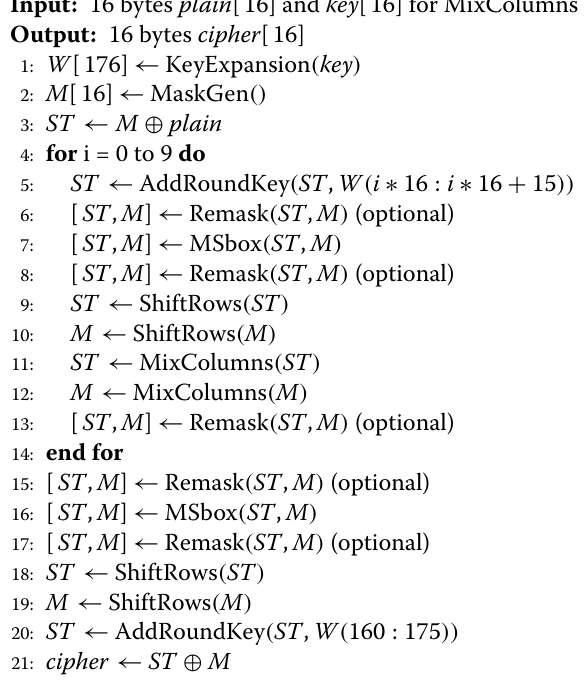
Algorithm 1 A general first-order Masked AES-128